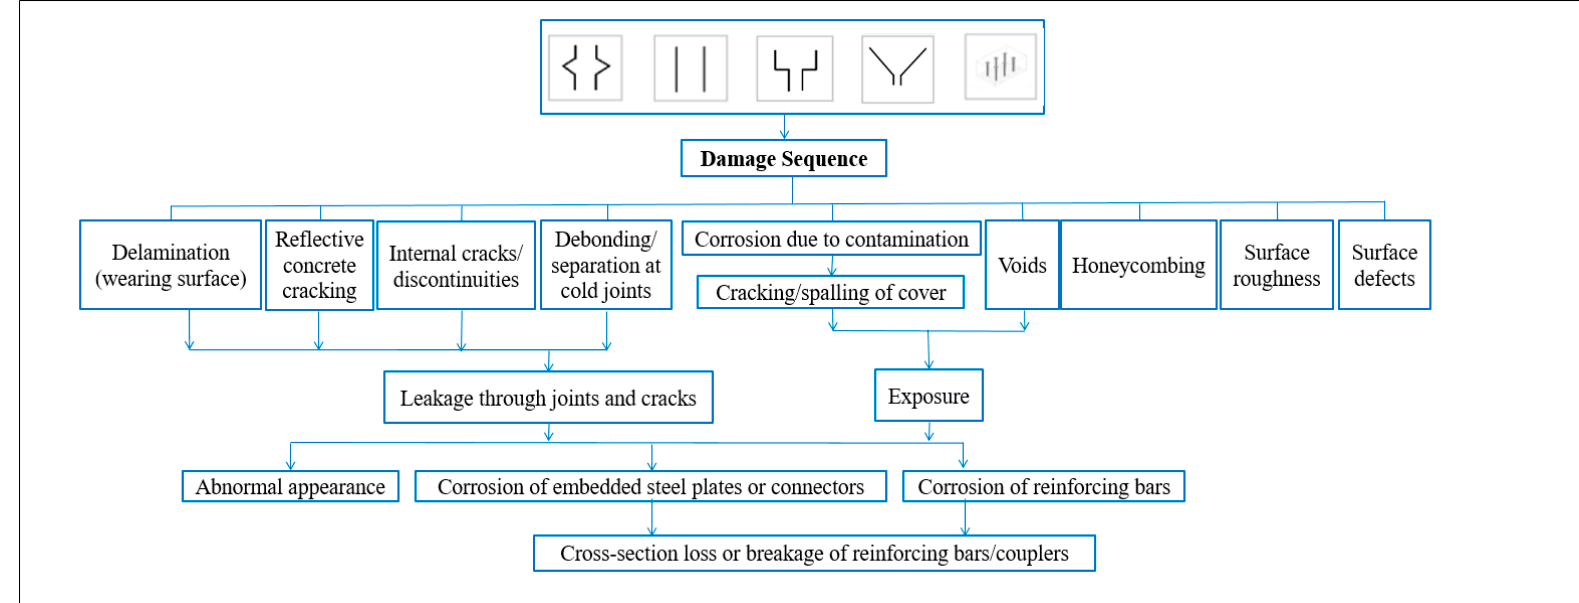
Figure 3. Damage sequence tree (DST) for ABC closure joints.